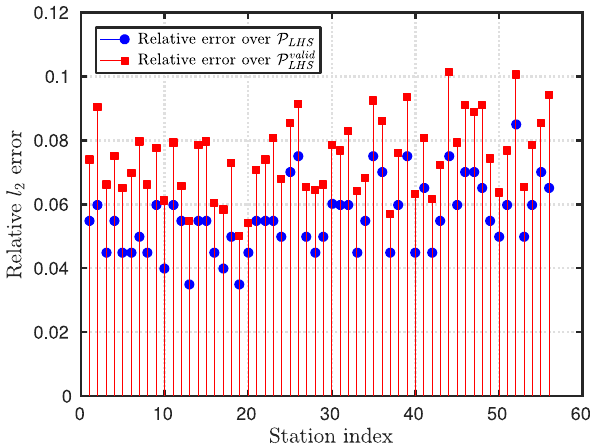
Figure 3. Relative l 2 errors of PC surrogate models. The cross- validation errors are close to the error estimated from validation set. For brevity, we omit the cross-validation errors in the plot.